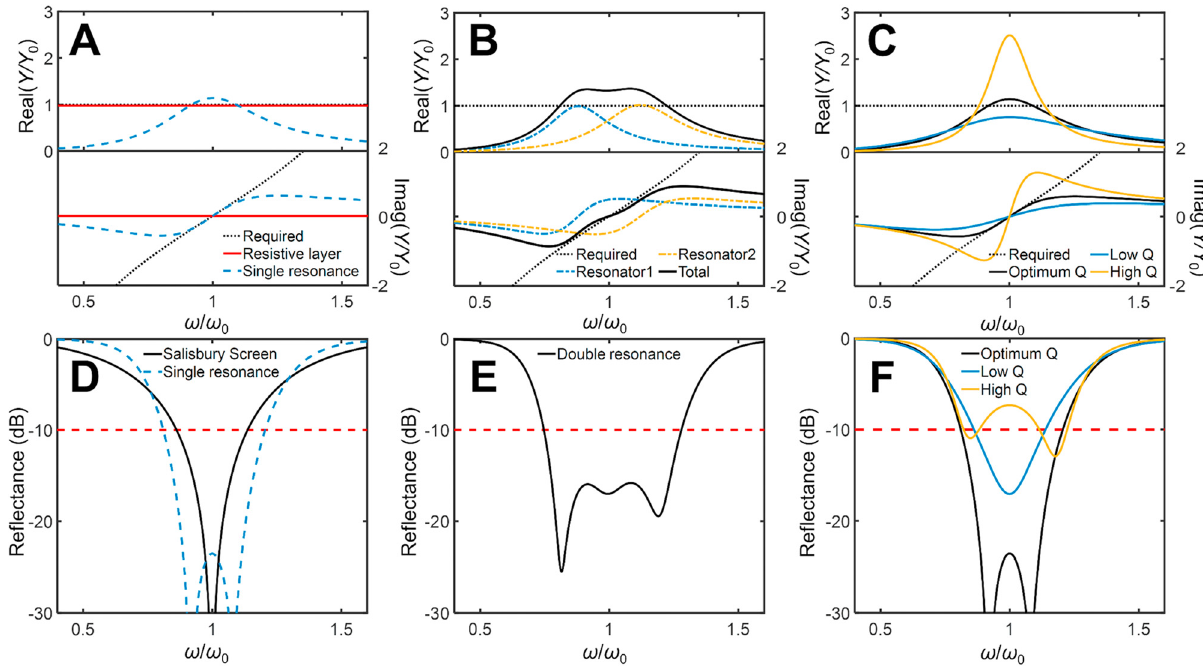
Figure 7: Concept of admittance matching for the structure in Figure 6A with λ /4-thick dielectric spacer. (A – C) Complex admittances required of the admittance-matching layer for perfect absorption are plotted as black dotted lines. Also shown are the actual admittance that can be realized by (A) top resistive layer of the Salisbury screen, (B) a double-resonance metasurface, and (C) a single-resonance metasurface. Top and bottom panels represent real and imaginary parts of admittances, respectively. In (A), blue dashed lines represent admittance of single resonance for comparison. In (B), blue and yellow dashed lines represent the contributions to the admittance from each resonance and the solid line corresponds to the combined admittance of the double-resonance metasurface. In (C), admittances attained from a single- resonancemetasurface with different Q factors are plotted, showing that a proper quality factor of the resonatorcan be chosen to enlarge the bandwidth. (D – F) Re fl ectance of different absorber structures are compared: (D) Salisbury screen, (E) metal-backed metasurface with double resonance, and (F) metal-backed metasurface with single resonance. Red dashed lines represent − 10 dB re fl ectance, which is a commonly used target in the